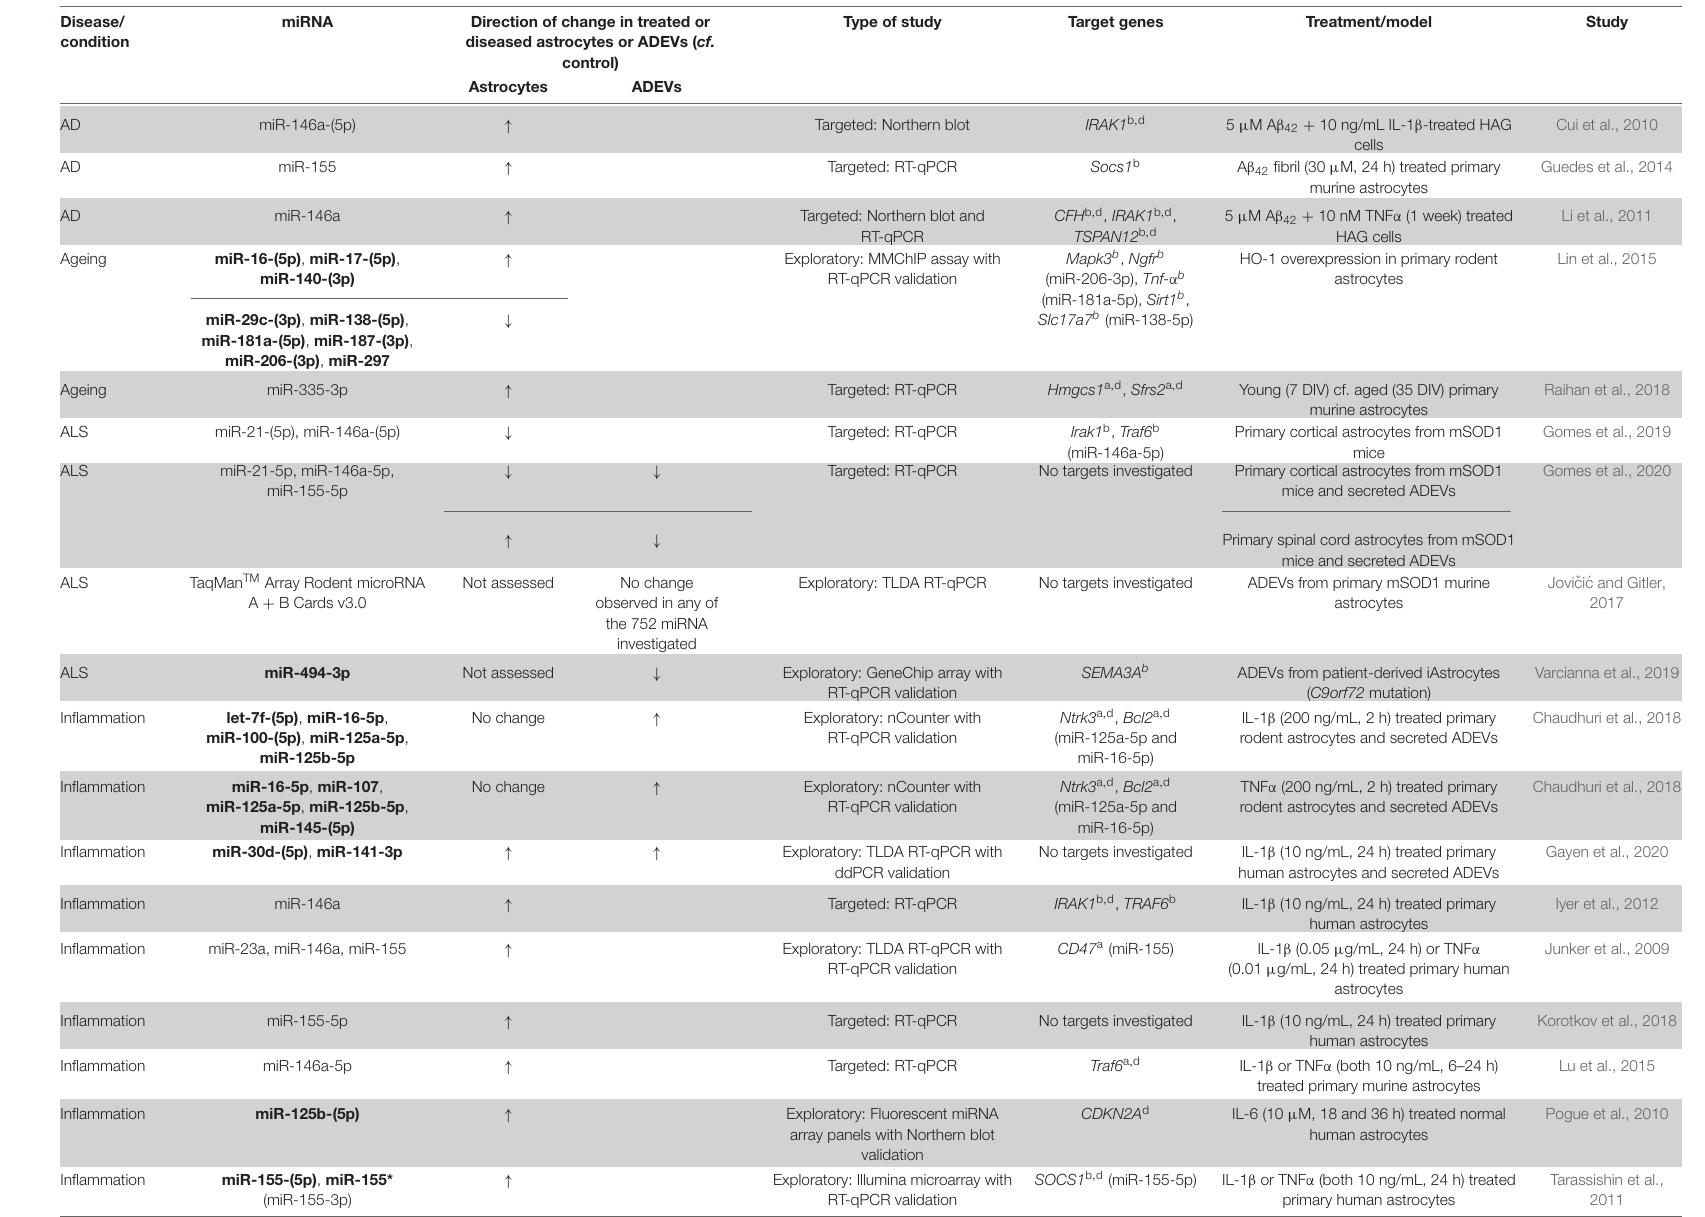
TABLE 1 | Differentially expressed microRNA in astrocytes and astrocyte-derived extracellular vesicles in ageing, inflammation, and neurodegenerative disease. Disease/ miRNA Direction of change in treated or condition diseased astrocytes or ADEVs (